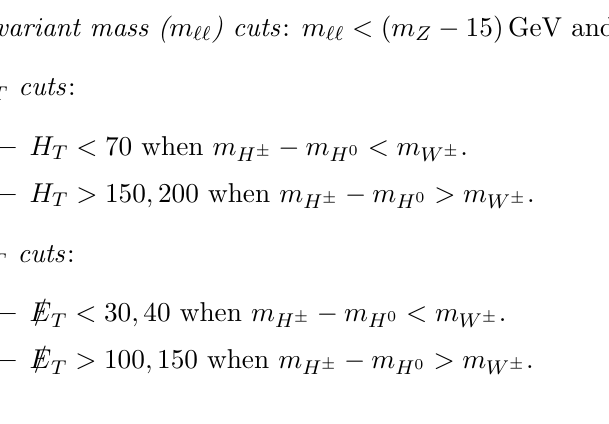
table 5. The distributions of =E distribution shifts to higher value as shown in (cid:12)gure 30. In such cases the signal events for large (cid:1) M can be separated from SM background at a suitable lower end cut of =E and H T